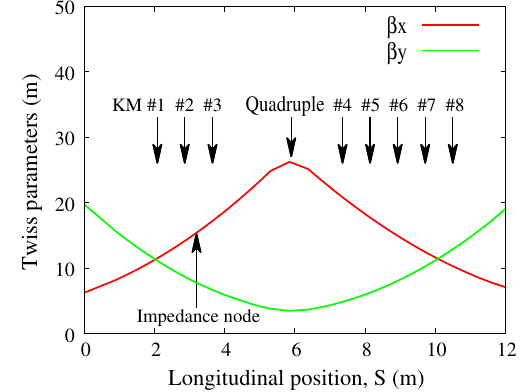
FIG. 9. Twiss parameters ( β x and β y ) in the extraction kicker region. The impedance node in the simulation is placed at the average β x , as shown by the red arrow.